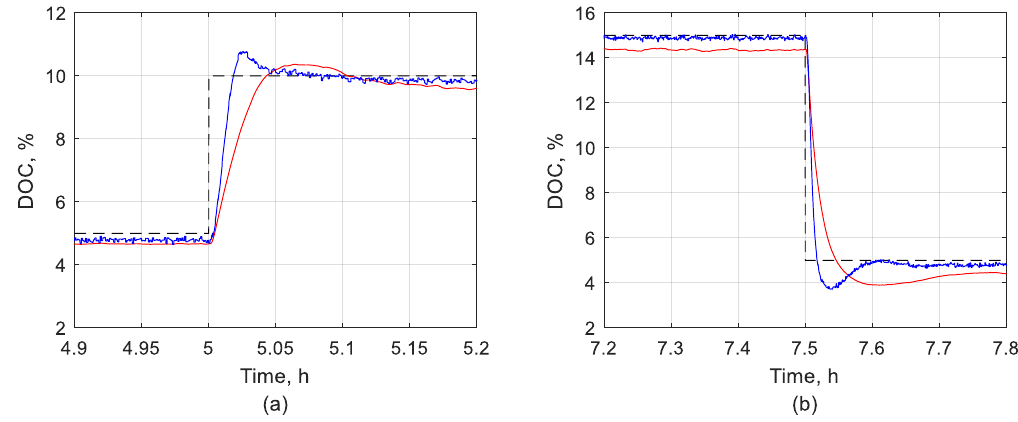
Figure 4. DOC responses ( a ) and ( b ) to set-point change: PI controller with fixed parameters (red), adaptive PI controller with Gain Scheduling (blue), DOC set-point (black).